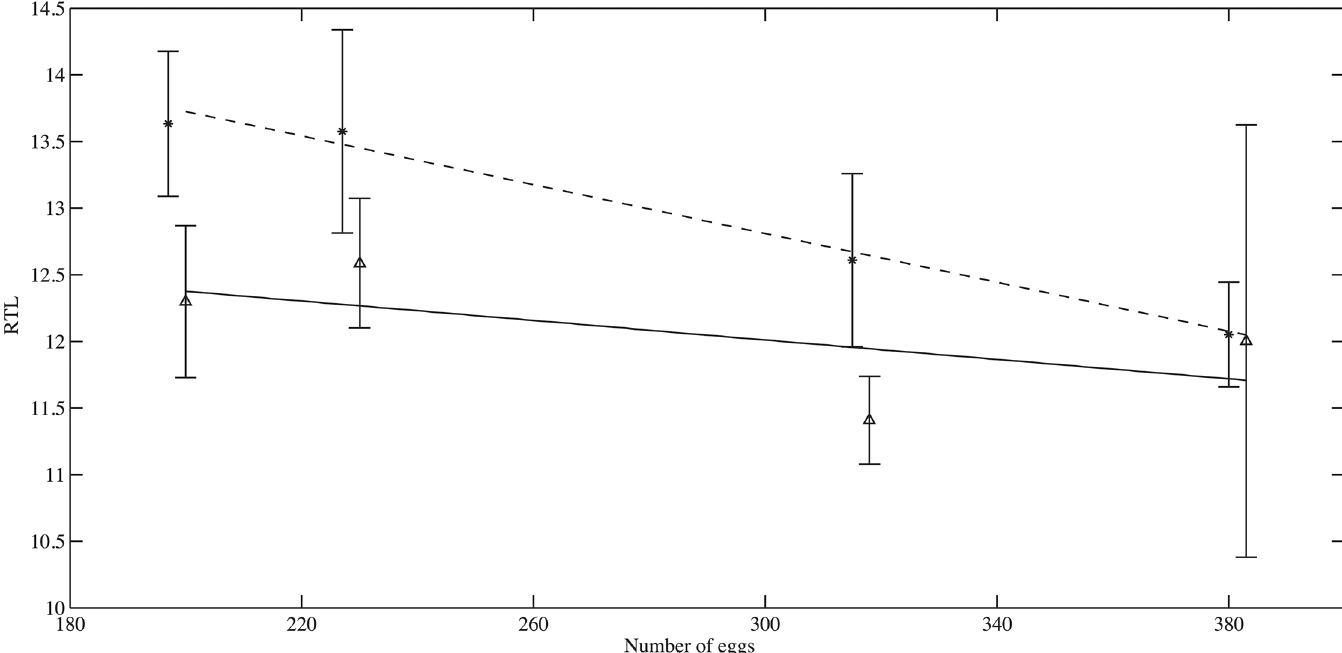
Fig 4. Correlation between average female fecundity and average telomere length across tanks. Muscle samples are marked with star and brain samples are marked with triangle. The dashed line and solid line is linear fit to muscle samples and brain samples